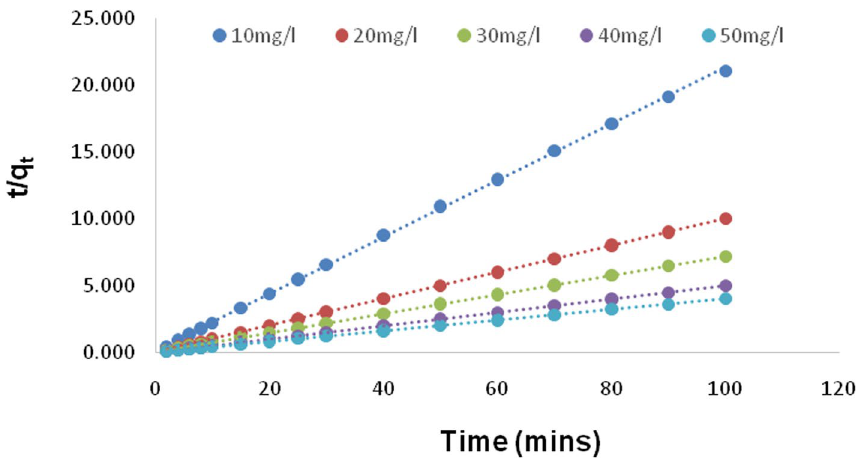
Fig. 4 Plot of pseudo-second- order kinetic model at 30 °C for ibuprofen adsorption onto